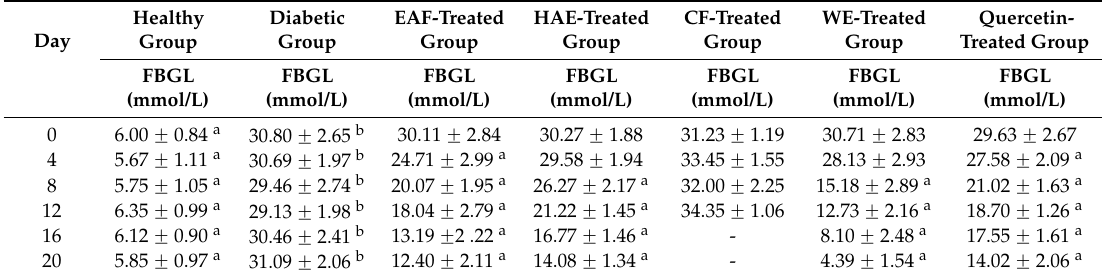
Table 2. The in vivo hypoglycemic activity assay results for the tested groups. Each value is the mean ˘ SD for six mice in each group. The empty cells in the table are because the mice in the CF-treated group did not survive past Day